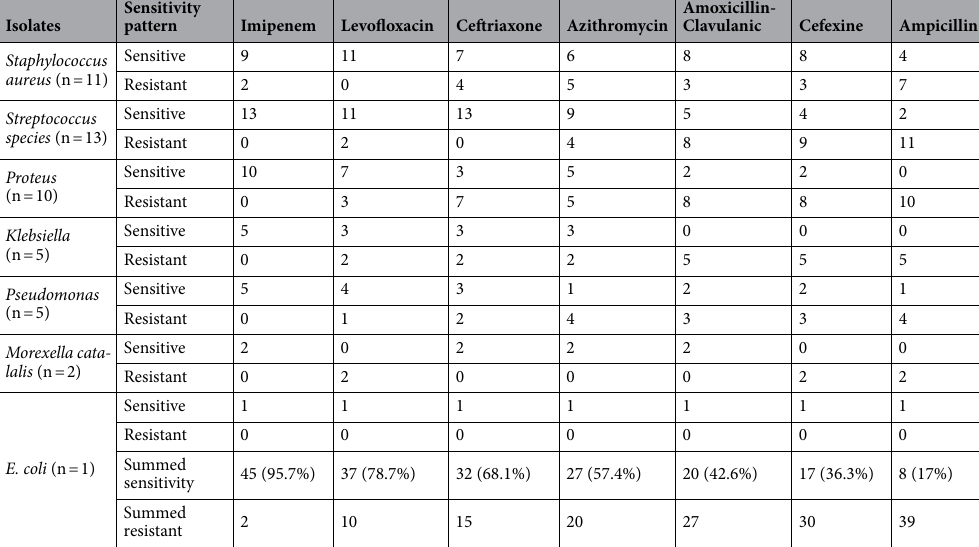
Table 3. The Antibiogram susceptibility and resistant pattern of the microbiota isolates.